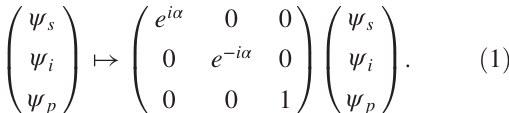
and energy ω ( P ), which p p